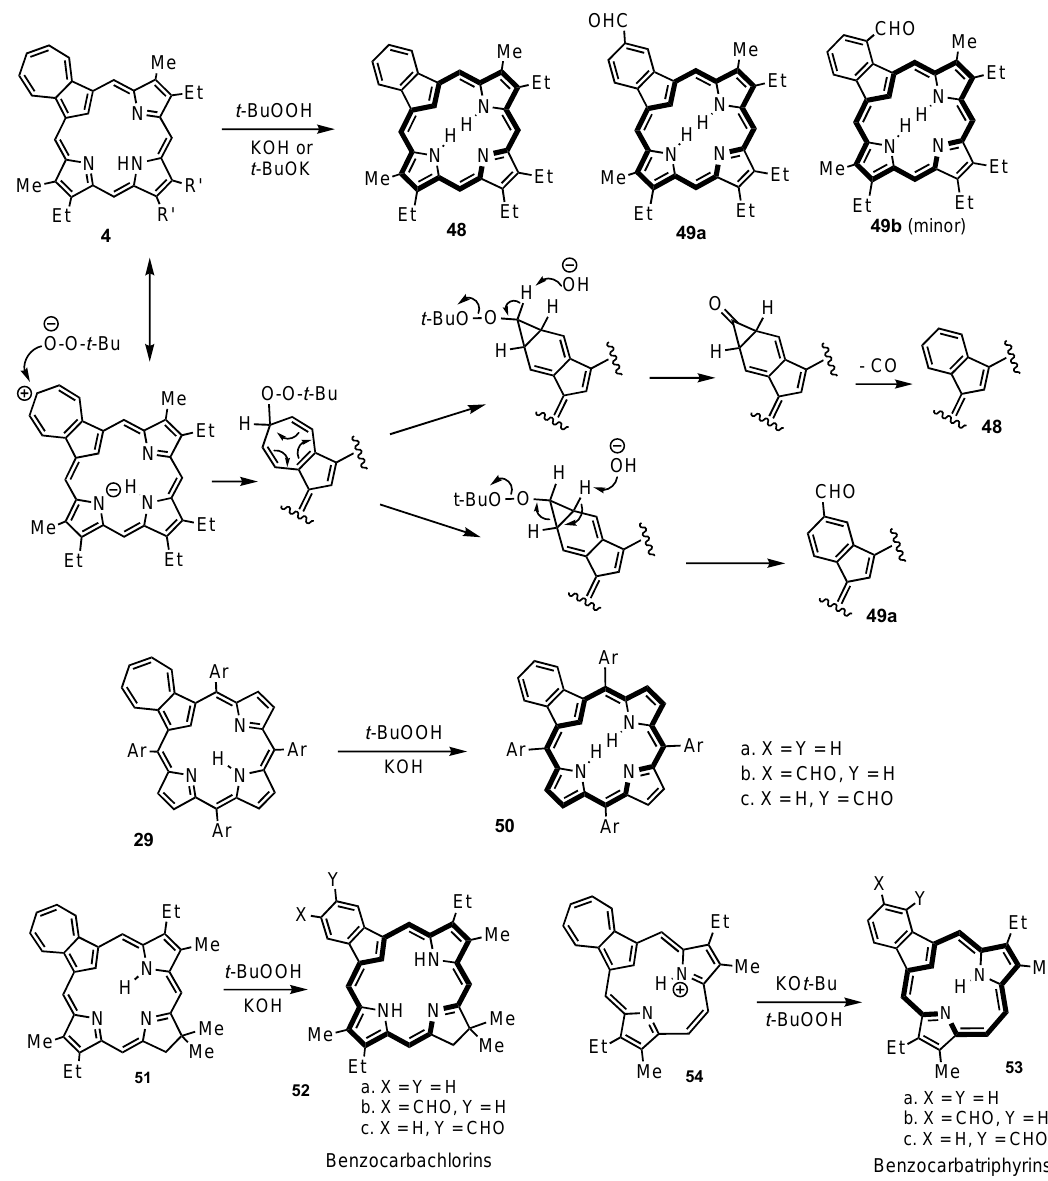
Scheme 11. Oxidative ring contraction of